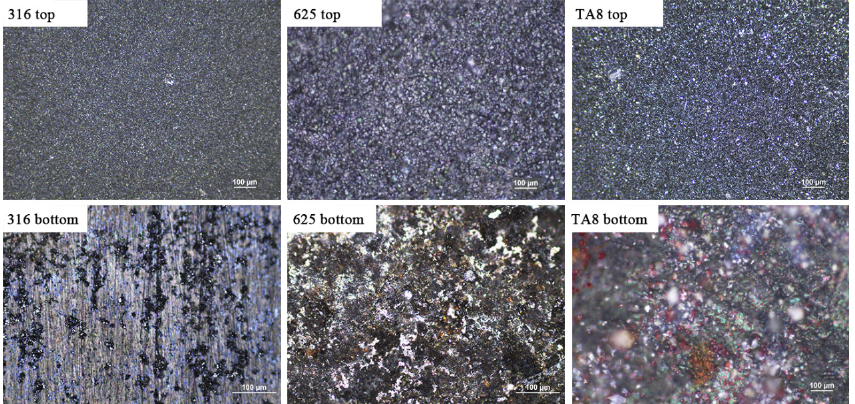
Figure 2. The images of 316 SS, Alloy 625, and TA8 after exposure to SCW at experiment Run-6 for 200